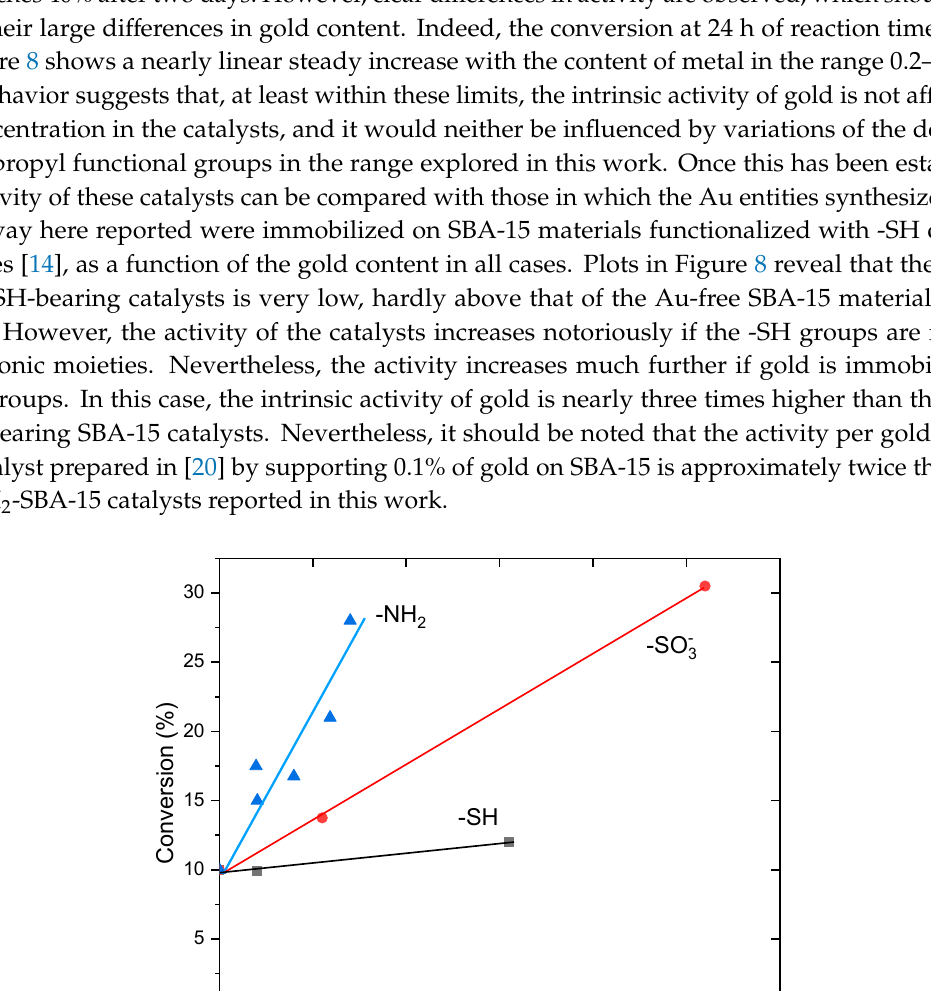
11 of 19 Figure 7. Conversion as a function of time for the liquid phase oxidation of cyclohexene with selected